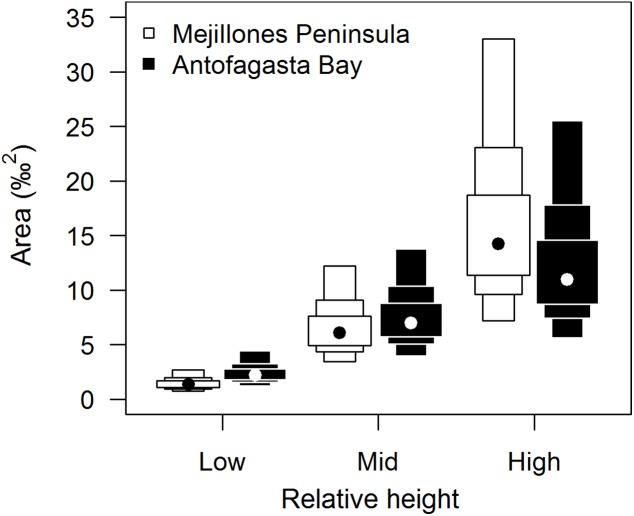
Comparison of isotopic niche widths (SEA.B) of E. peruviana individuals, grouped by relative height on shore, over Antofagasta Bay (black boxes) and Mejillones Peninsula (white boxes).This geographical split follows the ecological differences identified over this region by Reddin et al. (2015). Plotted are 95, 75 and 50% credible intervals (boxes) and the mode (black or white dot). Sample sizes per height level for both geographical groups, ‘low’ n = 10, ‘mid’ n = 10, ‘high’ n = 7.